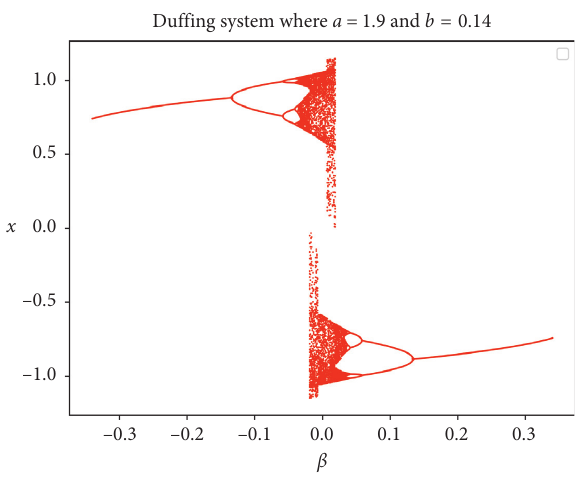
Figure 24: Bifurcation diagram of β